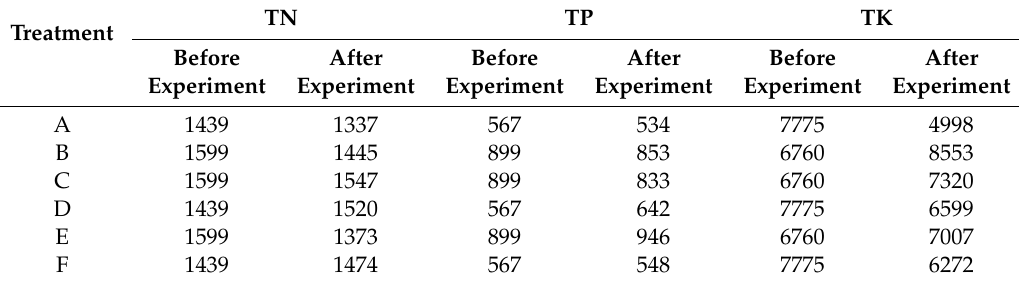
Table 3. Nutrients (kg ha − 1 ) in experimental soil before and after